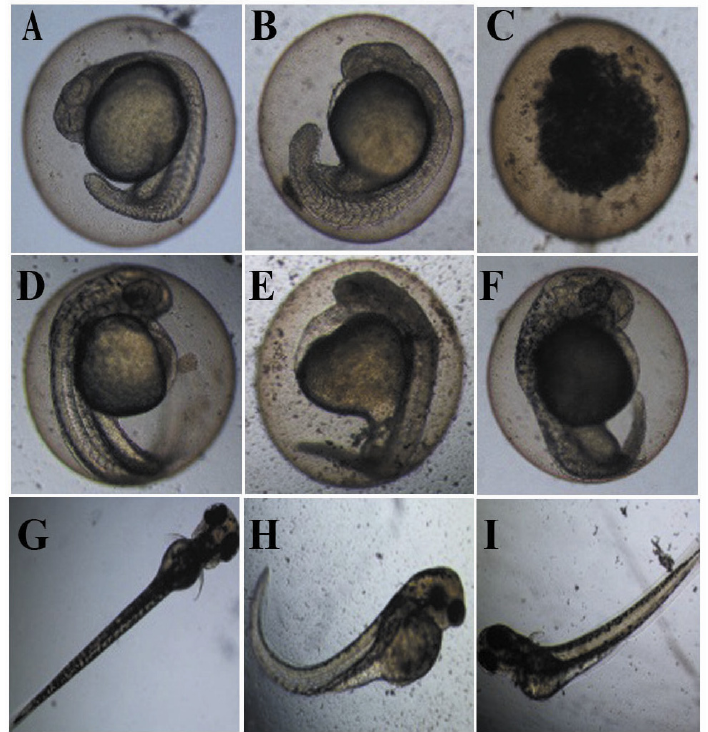
Figure 3. Pictures of the early embryonic development of zebrafish embryo exposed to post-treated slurry (( a ) 24 h-normal development; ( b ) 24 h-no extension of the embryonic tail; ( c ) 24 h-coagulated egg; ( d) 48 h-normal development;( e ) 48 h-pericardial edema; ( f ) 48 h-pigment deposition; ( g) 72 h-normal development; ( h , i ) 72 h-malformed larvae treated with